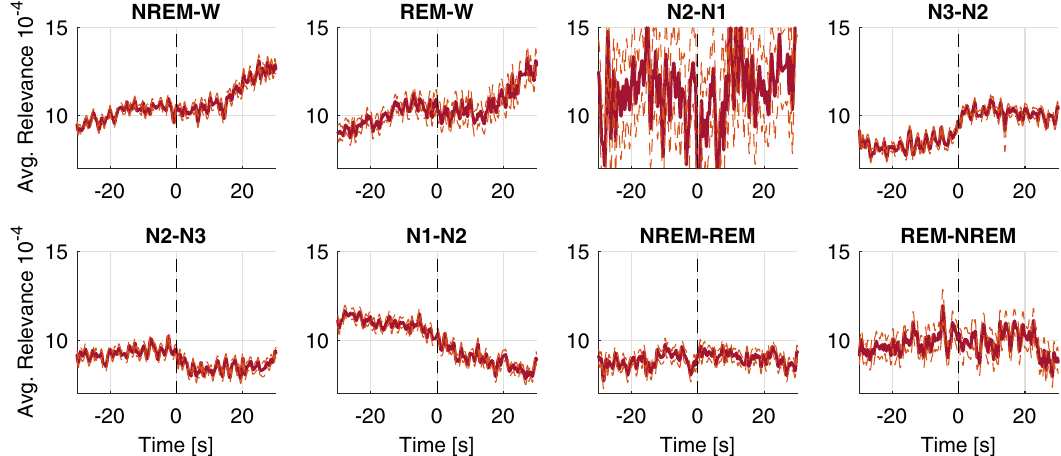
Fig. 3 Average and smoothed relevance attribution averaged over channels of model (b; EEG + EOG + EMG) time-locked to sleep-stage transitions. The average relevance attribution time-locked to sleep-stage transitions. These were averaged in 4353 PSGs from the test set with available manual scoring. The dotted line marks the standard error of the mean. Relevance attribution was computed using gradient